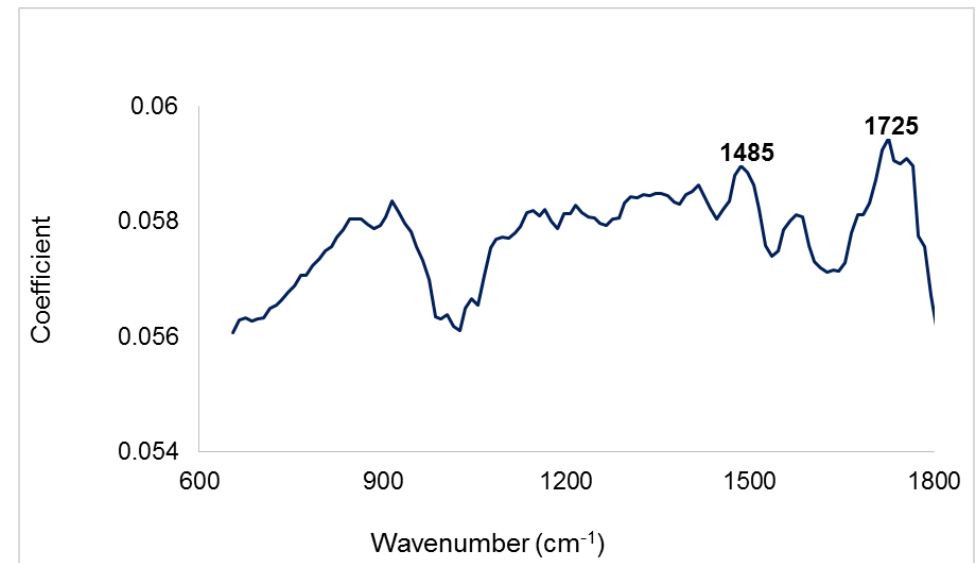
Figure 6. FTIR loadings plot of PC 1 showing significant peaks.